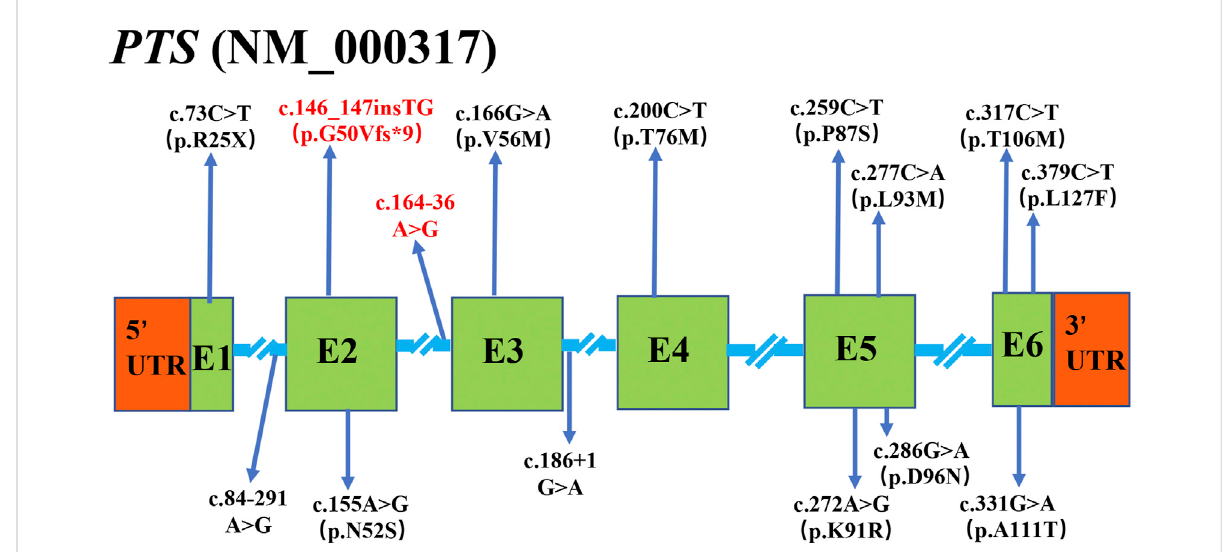
FIGURE 1 The results of Sanger sequencing in 53 patients with PTPSD. 15 kinds of variants located in all the coding exons (E) and primary splice sites (blue line) of PTS gene. The novel mutation was marked with the red